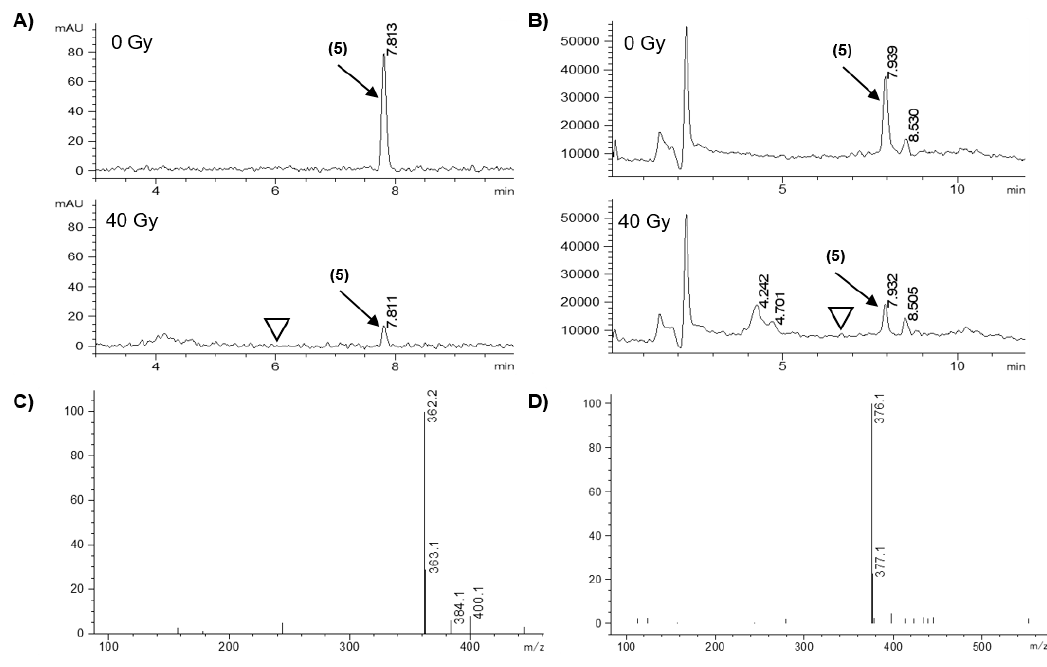
Figure 4. LC / MS analysis of the radiolytic reduction of model HAP 5 . ( A ) Diode array chromatograms at 276 nm (bandwidth 16 nm), with 0 and 40 Gy. ( B ) Total ion chromatograms (positive mode, scanning m / z 100–600), with 0 and 40 Gy. ( C ) Mass spectrum of peak at retention time 4.701 min (identified as hydroxylamine). ( D ) Mass spectrum of peak at 7.932 min (identified as prodrug by comparison with authentic 5 ). (cid:53) Indicates the retention time of the parent PARPi 4